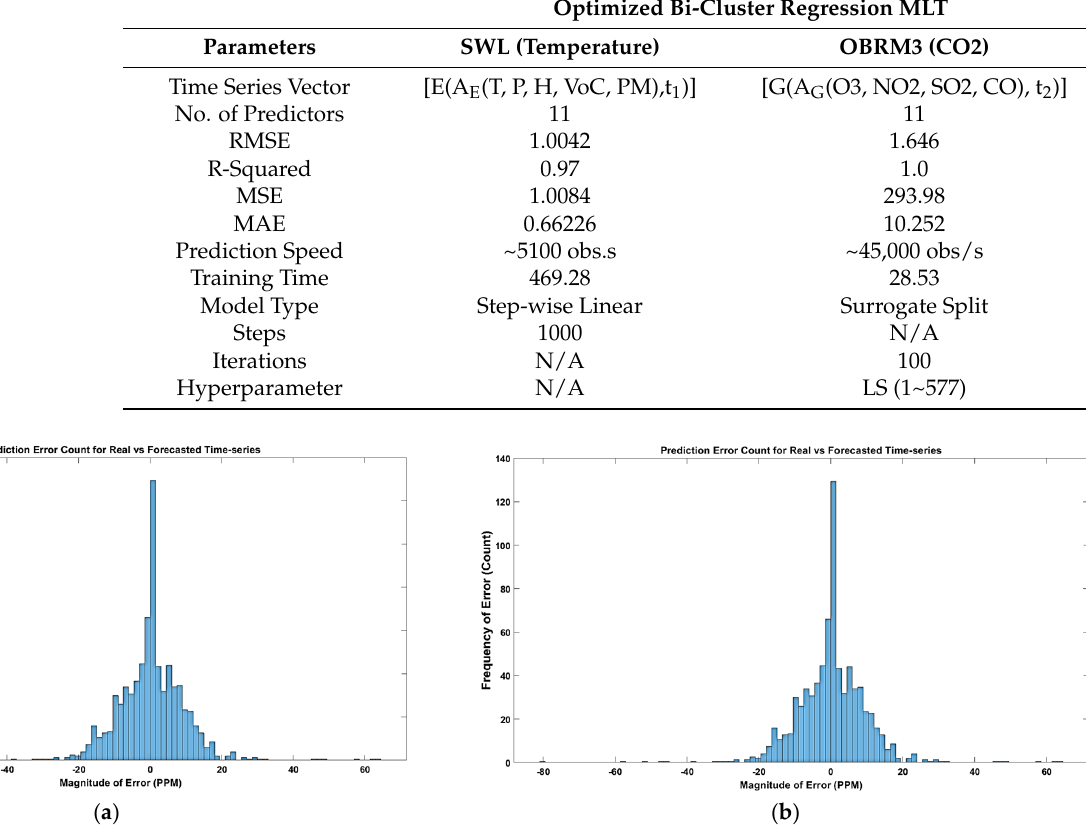
Figure 17. Iterative Parametric Optimization of the Prediction Errors using Predictors Sets and Frequency of Prediction Errors: ( a ) The Prediction of Error in the count for OBRM3 and ( b ) The Probability of Prediction of Error in the count for OBRM3.